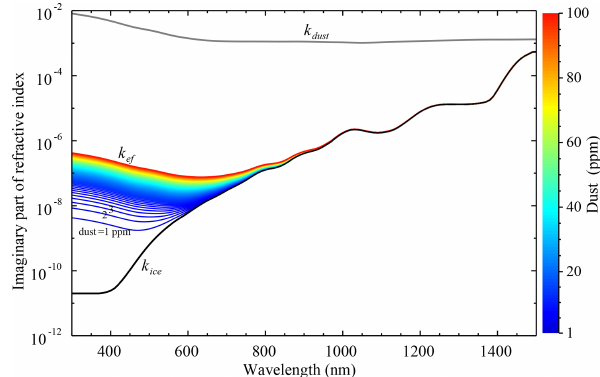
Figure 3. Imaginary part of the spectral complex refractive indices of ice ( k ice ) and dust ( k dust ) (Warren and Brandt, 2008; Dang et al., 2015), with the imaginary part of the effective complex refractive indices ( k ef ) as a function of wavelength, at dust mass concentra- tions (C ∗ ) of 1–100ppm (or µgg − 1 ) in dust